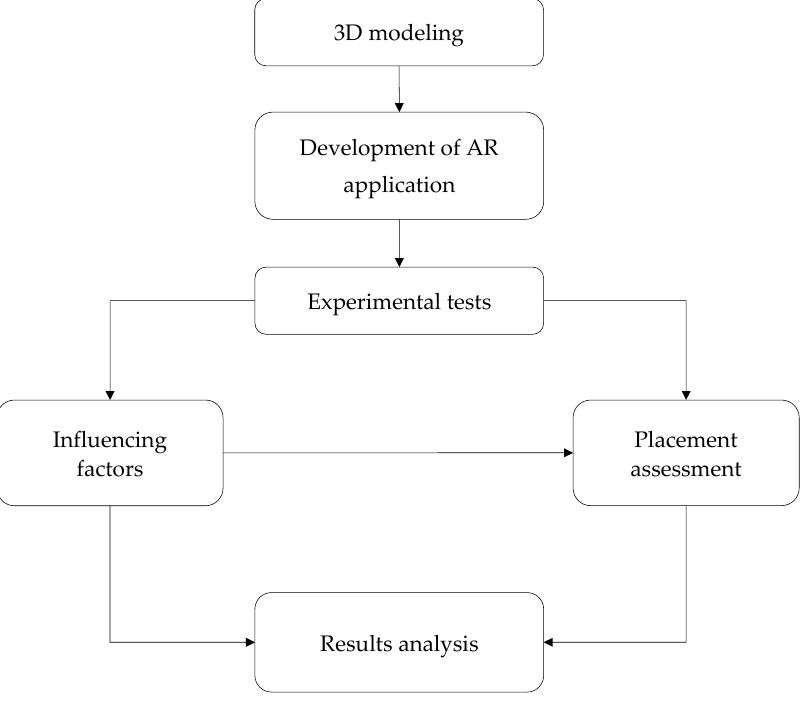
Figure 2. The adopted methodological workflow.